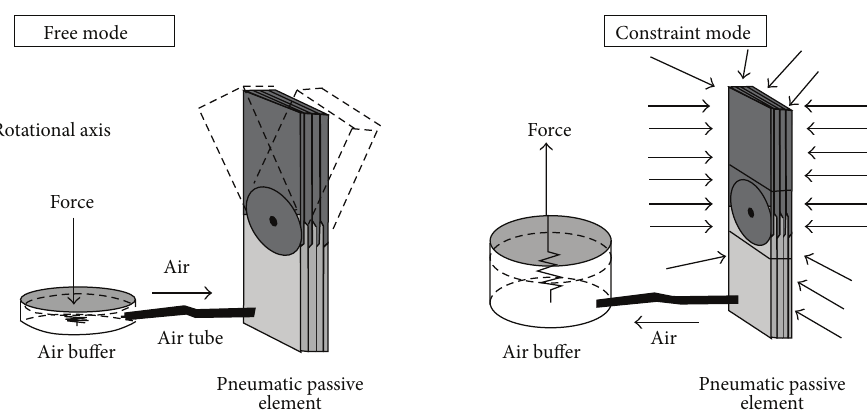
Figure 3: Free and constraint mode of passive pneumatic element